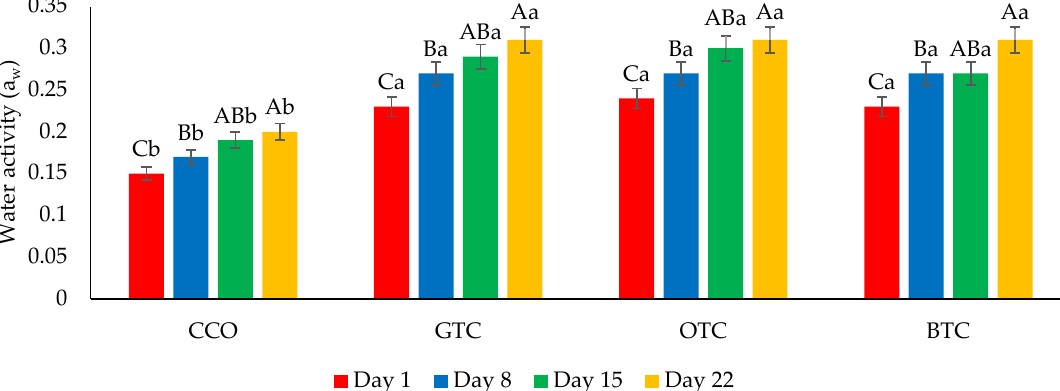
Figure 5. Water activity (a w ) of non-gluten shortbread cookies with various spent tea leaf powders during di ff erent storage periods (day 1, 8, 15, and 22) at 25 °C. The mean ± SD ( n = 3). Di ff erent le tt ers indicate signi fi cant di ff erences between the values (Duncan’s multiple range test, p < 0.05, a,b cookie samples, A–C storage). CCO = control; GTC = non-gluten shortbread cookies with spent green tea leaves powder; OTC = non-gluten shortbread cookies with spent oolong tea leaves powder; and BTC = non-gluten shortbread cookies with spent black tea leaves powder.